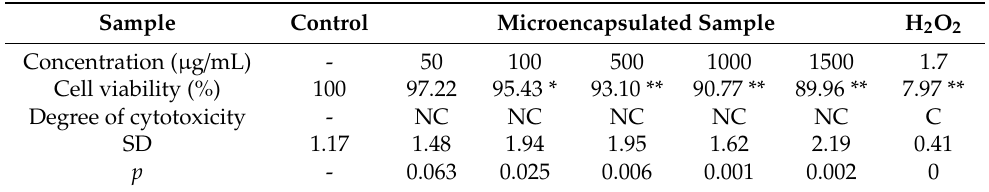
Table 4. Values and statistical analysis of L929 cell viability after cultivation in the presence of different concentrations of microencapsulated samples, for 24 h, determined by 3-(4,5-